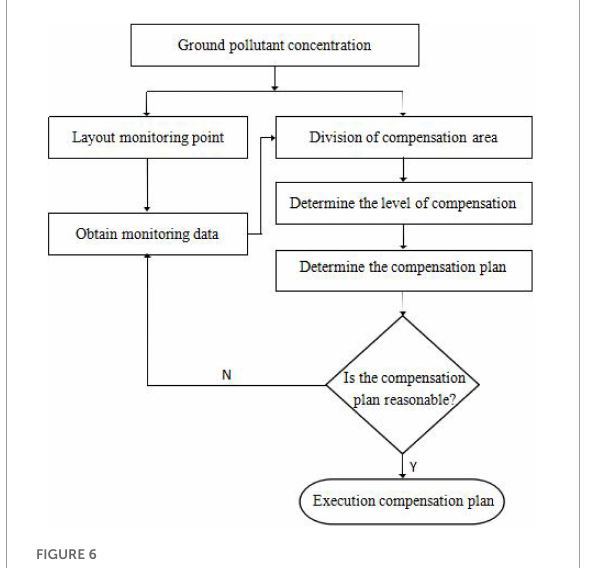
FIGURE6 Flow chart for developing an economic compensation plan.